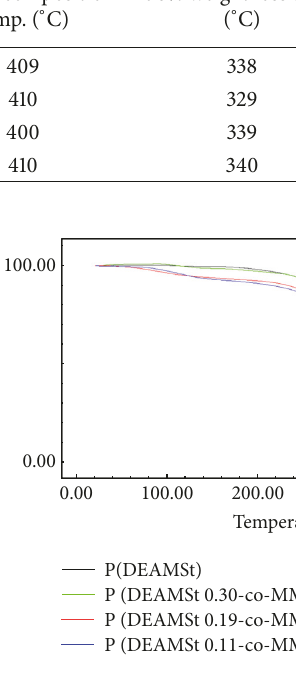
Figure 8: TGA curves of P(DEAMSt) and P(DEAMSt-co-MMA).